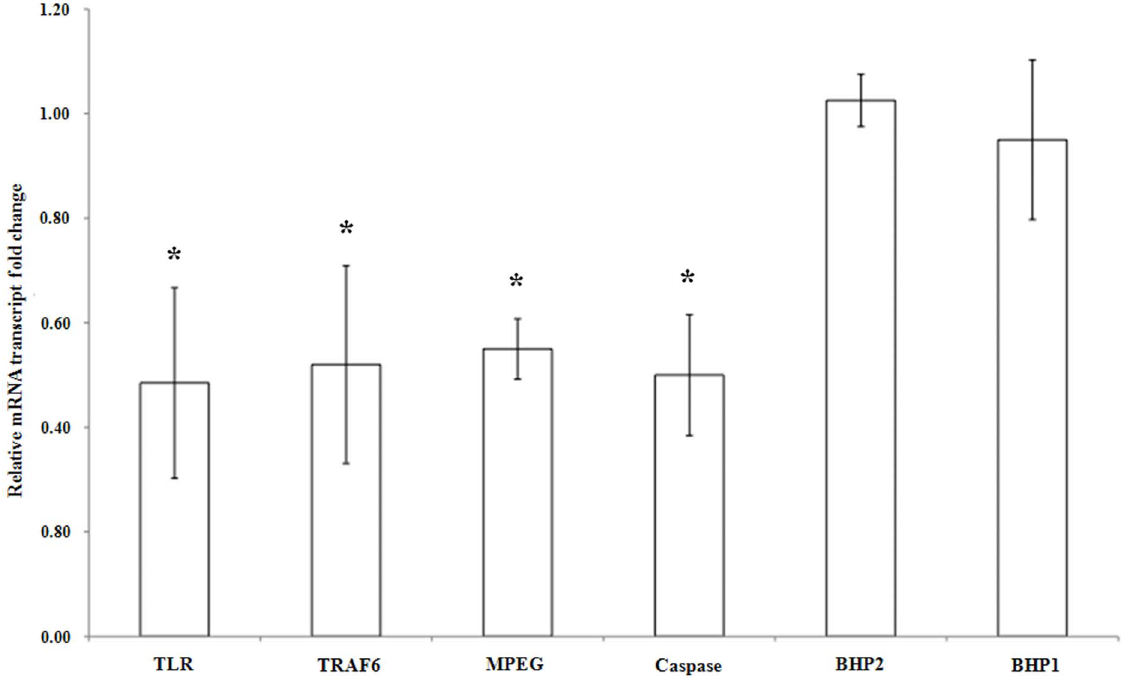
Figure 2. Relative amounts of transcripts for Toll-like receptor (TLR), Toll-like Receptor associated factor 6-like protein (TRAF 6), Macrophage-Expressed Gene protein (MPEG), caspase-like 3/7, BCl-2 homolog protein-1 (BHP-1) and BCl-2 homolog protein-2 (BHP-2) in N -3-oxododecanoyl- L -homoserine lactone (3-oxo-C 12 -HSL)-stimulated Suberites domuncula compared to control S. domuncula . The mRNA levels in 8 h-stimulated S. domuncula were evaluated by quantitative reverse transcription-PCR and compared to those in control sponges. Reactions were performed in triplicate with three different specimens. Relative mRNA level values resulted from calculating values: values above and below 1 show a higher and a lower mRNA level in the presence of 10 2 6 M 3-oxo-C 12 -HSL, respectively. Significant expression changes (p , 0.05) in the presence of N -3-oxododecanoyl- L -homoserine are pointed out by an asterisk.